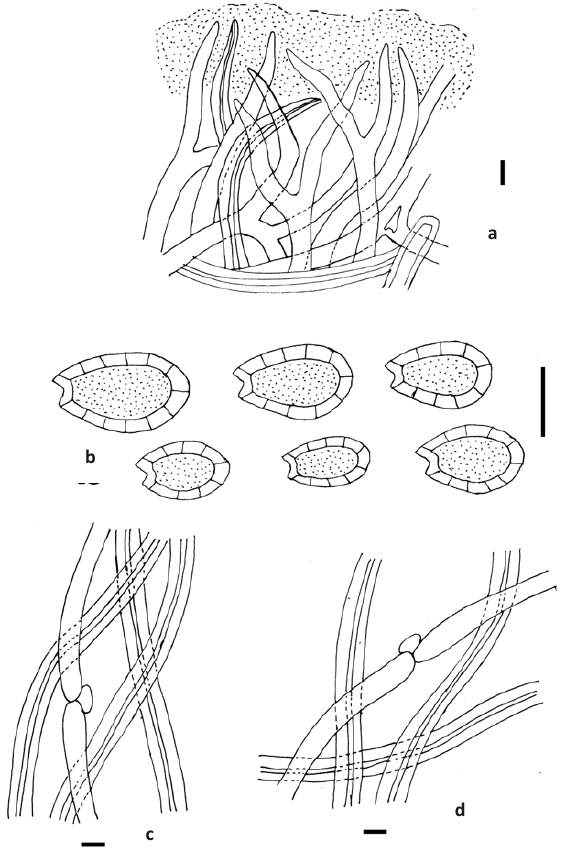
Figure 2. Ganoderma applanatum . a - hyphae of the cutis, b - basidiospores, c - context hyphae, d - tube layer hyphae. Bars = 5µm. Drawing by R.